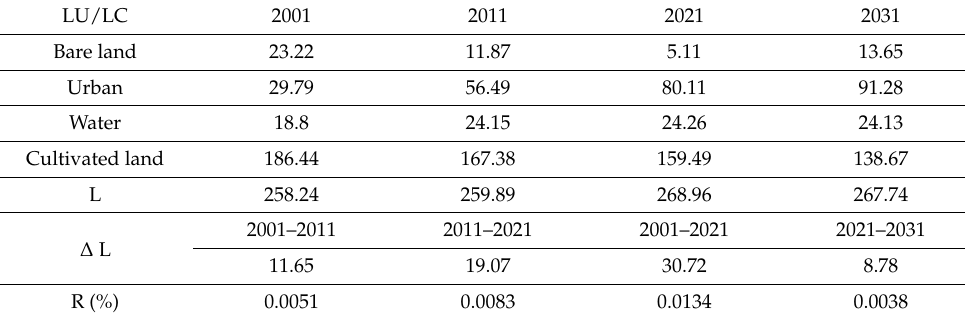
Table 11. Land use Dynamic of LU/LC.